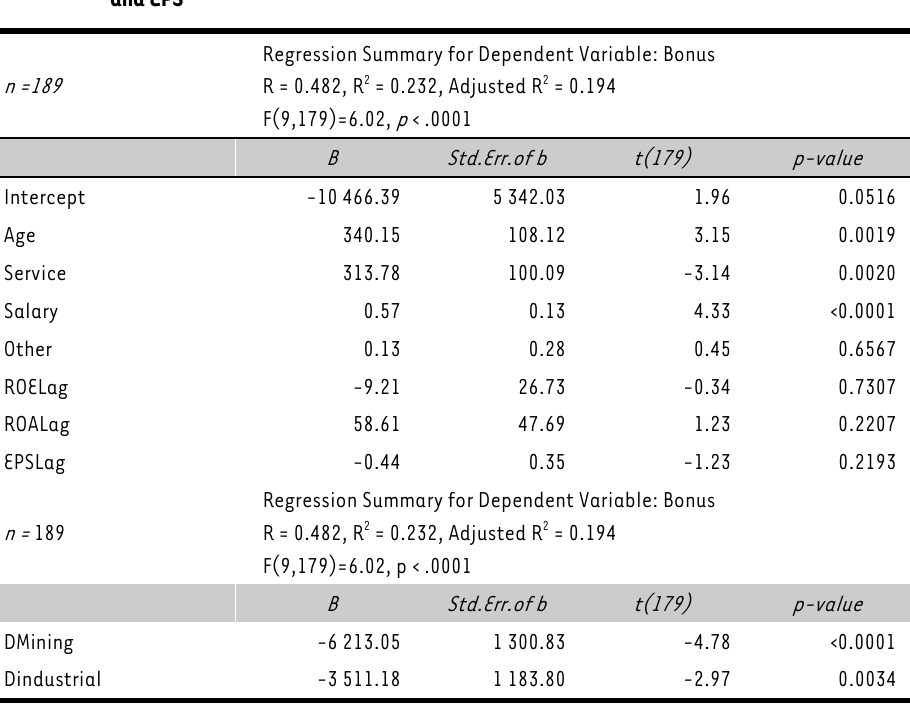
TABLE 4: Econometric Model 2 showing bonus as the dependent variable with lagged ROE, ROA and EPS Regression Summary for Dependent Variable: Bonus n =189 R = 0.482, R 2 = 0.232, Adjusted R 2 =